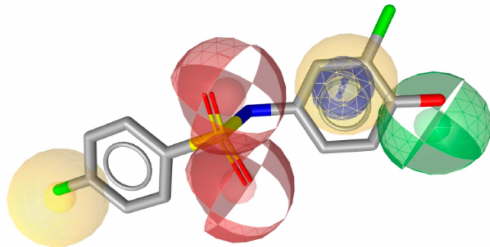
Figure 15. The selective 17 β -HSD2 model contains a HBD feature (green sphere), which is important for 17 β -HSD2 inhibitors such as the newly identified phenylbenzene-sulfonamide derivative 13 [141].